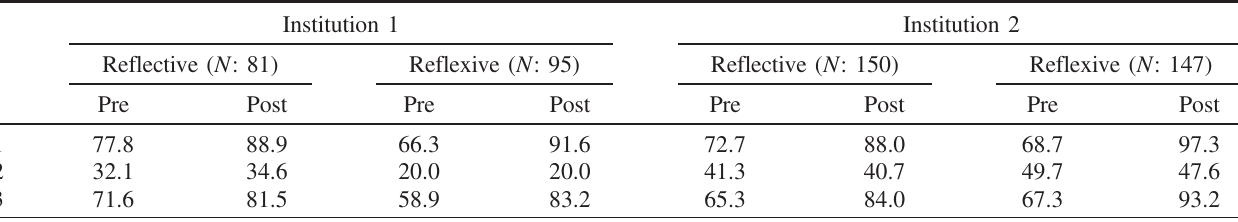
TABLE I. Percentage correct by question on the pre- and post-test, broken down by training condition, for each institution.